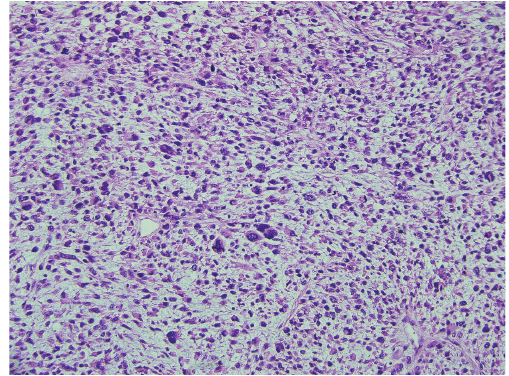
Figure 4: Pan-keratin, highlighting the residual ductal epithelium with no staining in tumor cells